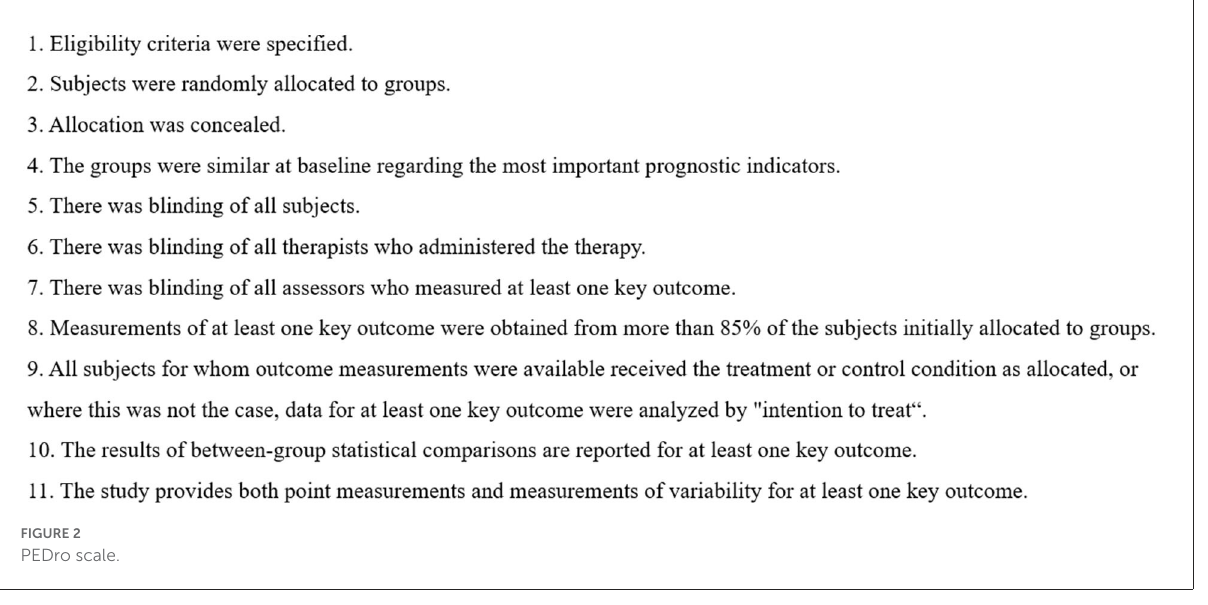
TABLE 1 Stimulation protocols and main outcomes of the studies investigating the effect of tDCS on motor skills